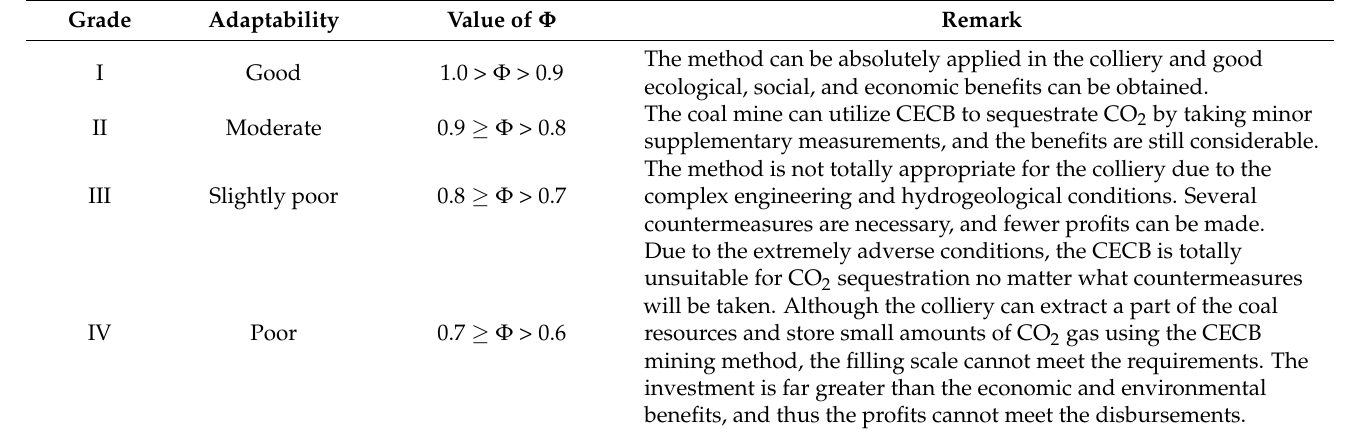
Table 4. Classification standard for predicting the adaptability of using CECB to sequestrate CO 2